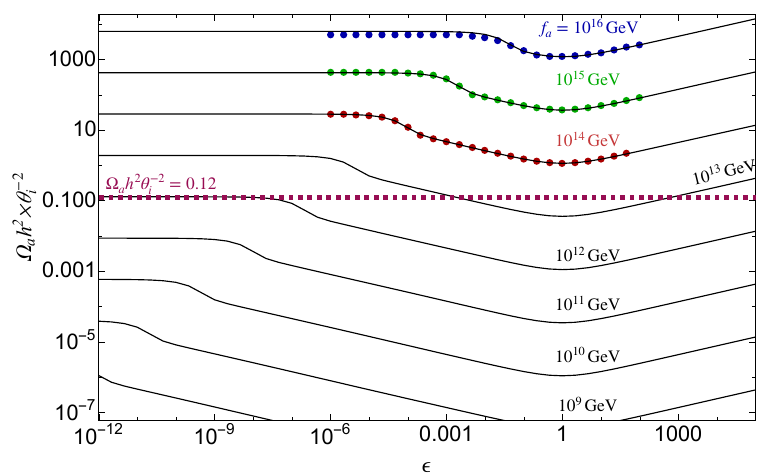
Figure 4 . The resulting abundance divided by θ 2 for the QCD axion with aligned small instanton i by varying the relative instanton contribution, (cid:15) . The data points are calculated numerically by solving the equation of motion and are for f a = 10 16 , 15 , 14 GeV from top to bottom. The solid lines are fitted from the data and correspond to f a = 10 16 , 15 , 14 , 13 , 12 , 11 , 10 , 9 , 8 GeV from top to bottom. The correct dark matter abundance with θ i = 1 is denoted by the purple dotted